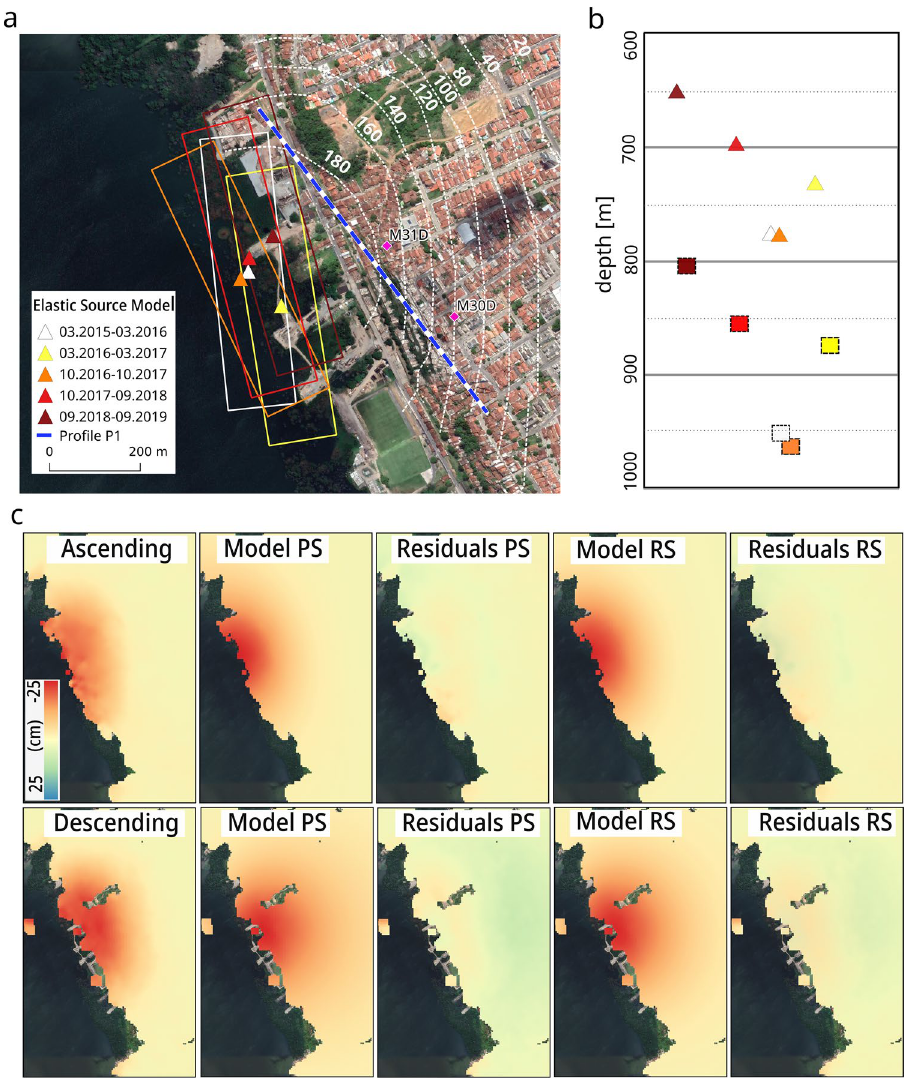
Figure 3. Inverse numerical model results. ( a ) Horizontal location of the best-fitting source models between 2016 and 2019: triangle symbology for point source model and solid rectangle for rectangular crack source model with different colours expressing the different dates as in legend. Dashed white isolines represent the cumulative displacement for the period 07.2004–11.2020. Magenta diamonds show the detailed location of the two cavities (M31D and M30D) modelled in DEM. The blue-white line shows the profile P1 used for the DEM subsidence simulation (see Figs. 4b and 5b). (b) Vertical profile reveals the depth of the best-fitting source models: triangles for point pressure source and rectangles for rectangle crack source (same colour convention indicating the date). X-axes is an indicative NW–SE along with the coast profile, not in scale. (c) InSAR ascending (Alos-2 data) and descending (Sentinel-1 data) observations for the period 2018–2019, best-fit model and relative residuals calculated by subtracting the model from the observations. PS indicates point source model; RS indicates rectangle crack source model. Background Google Earth CNES/Airbus imagery. The figures (except b ) were plotted in QGIS (v. 3.16, https:// www. qgis. org/ en/